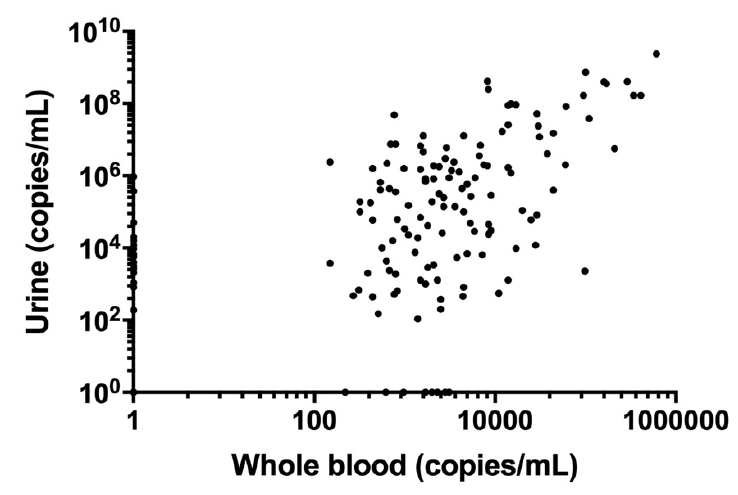
Figure 4. Correlation of viral loads in the whole blood and urine. Blood viral load significantly correlated with the urine viral load ( n = 155; y = 2198x − 8561549, r 2 = 0.579, p < 0.0001).